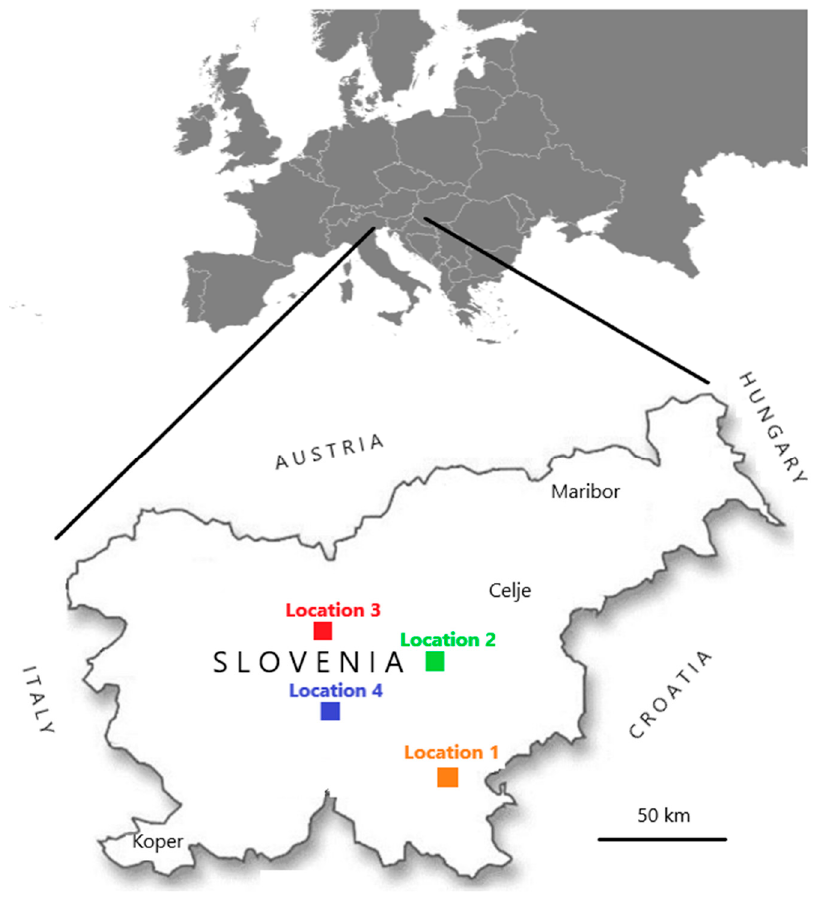
Figure 1. Four places (named Locations 1, 2, 3, and 4) in Slovenia where a total of 148 clinically healthy individual bumblebees and eight honeybee samples were collected during August 2017 and August